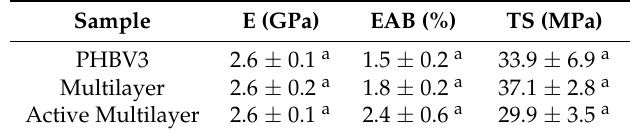
Table 4. Tensile parameters of the neat PHBV3 and PHBV films and the silver-based coating